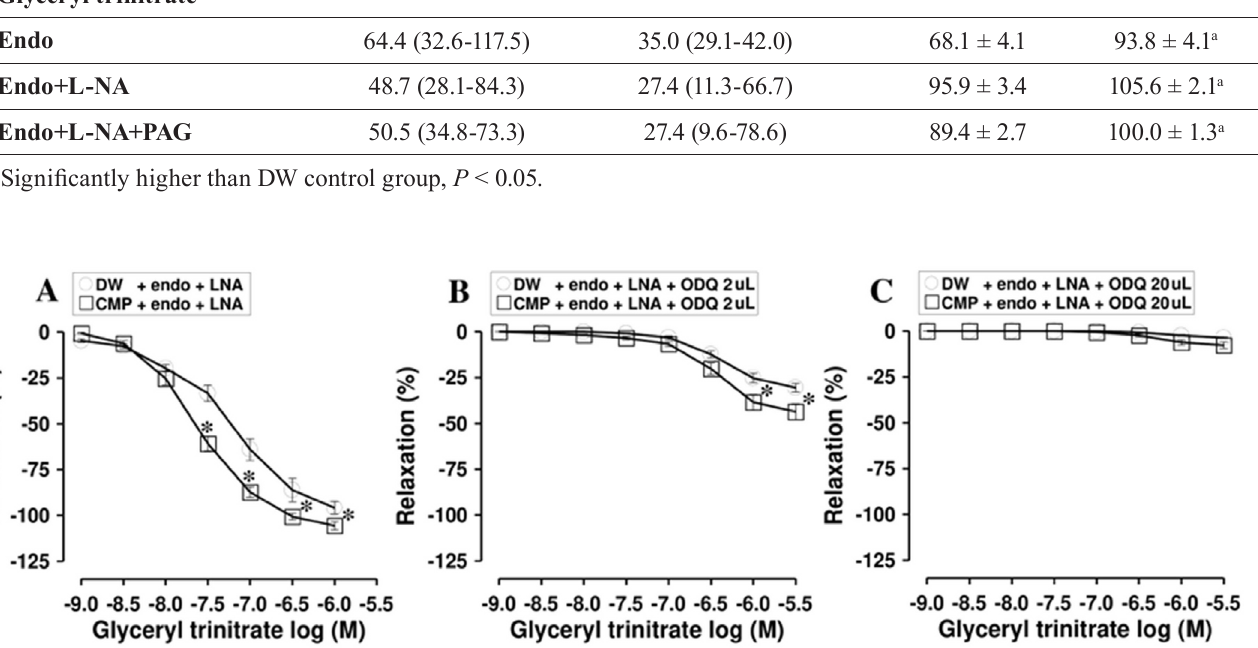
EC (nM) : 95% confidential limit 50